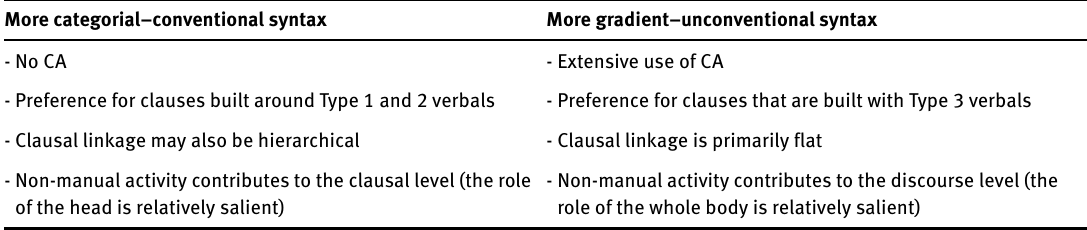
Table 9. Features of sign language syntax discussed in this paper associated with the